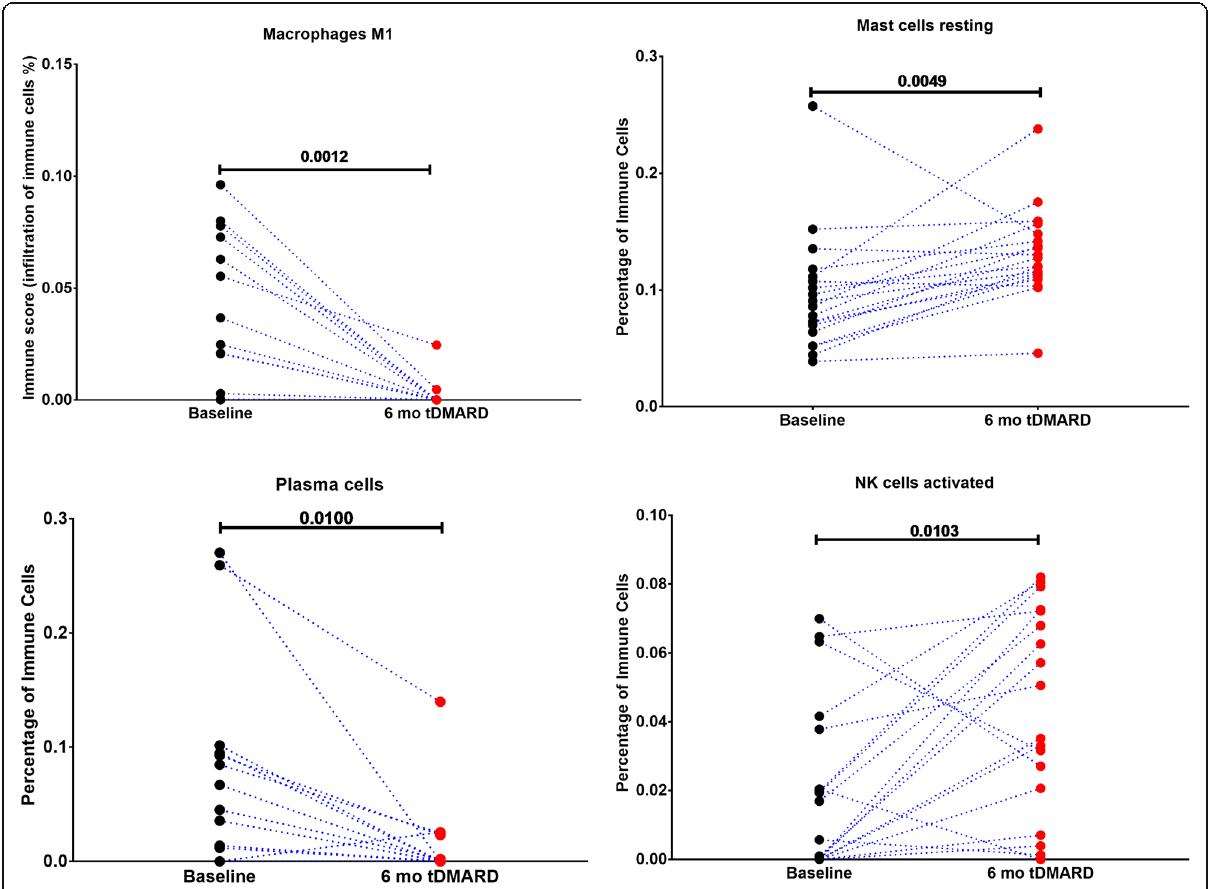
Fig. 4 Effect of tDMARDs Treatment In Early RA synovial immune cells profile. We used the publicly available synovial tissue transcriptomic data to compare the infiltration of the immune cells at baseline and after six months of tDMARDs to identify subgroups that might not respond well to tDMARDs. RNAseq dataset (GSE97165) of synovial biopsies taken from 19 early RA (defined as within 12 months of the onset of symptoms) patients at baseline and after six months of tDMARDs treatment were retrieved and reanalyzed. ANOVA test was used